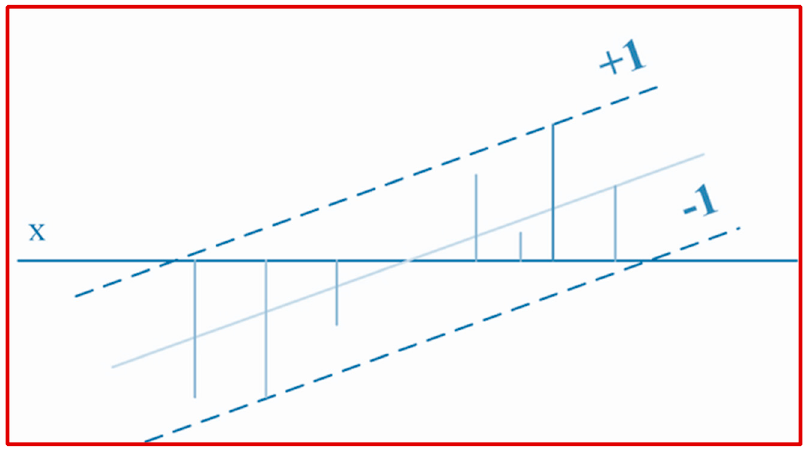
Figure 3. SVM arrangement for regression.